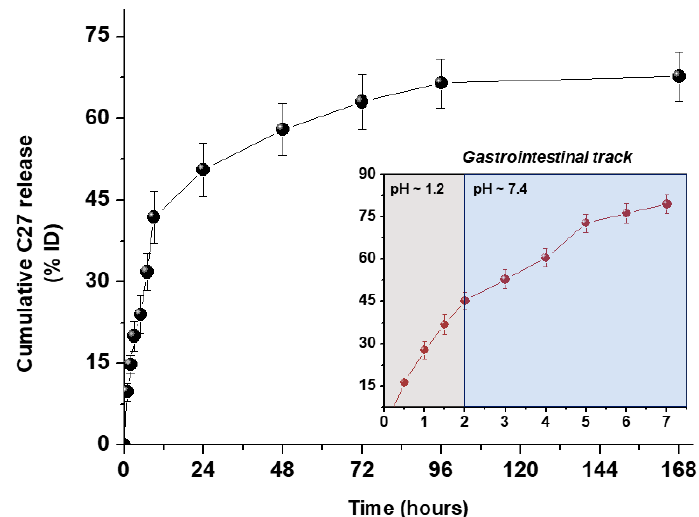
Figure 5. In vitro release profile of chromone C27 from PCL@C27 NPs in PBS (pH 7.4) conducted for seven days (black dot). Inset: In vitro release profile in 0.1 N HCl, pH 1.2, for 2 h followed by PBS, pH 7.4, for 5 h (red data). Results are presented as means ± SD of three independent experiments.